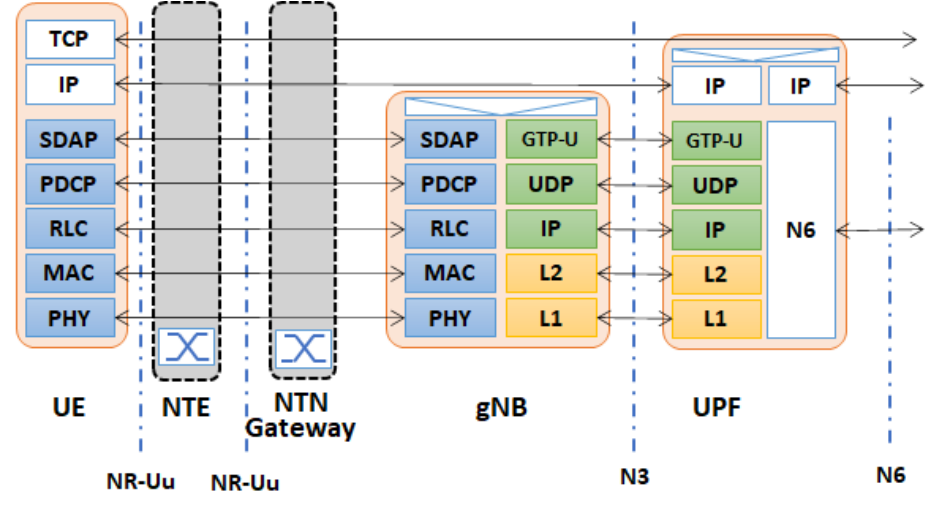
Figure 3. Protocol stack of the user plane in the transparent NTN architecture